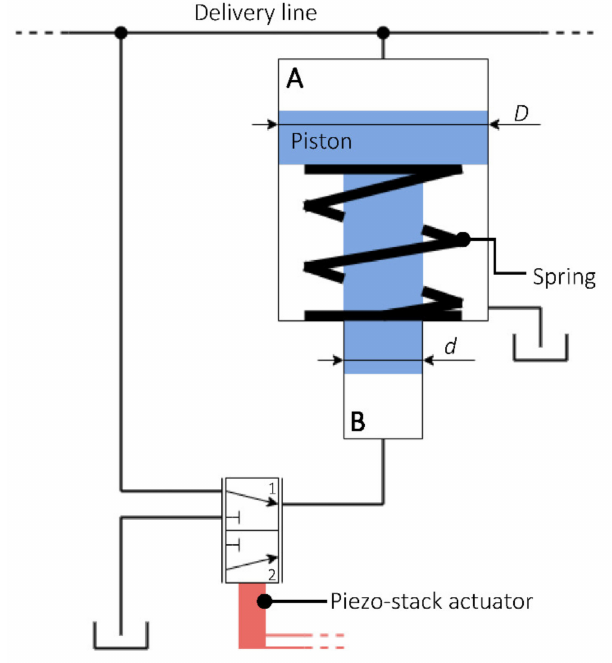
Figure 2. Schematic of hydraulically actuated piston active